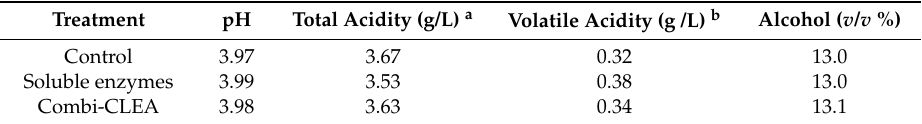
Table 3. Oenological parameters of Muscat wine.